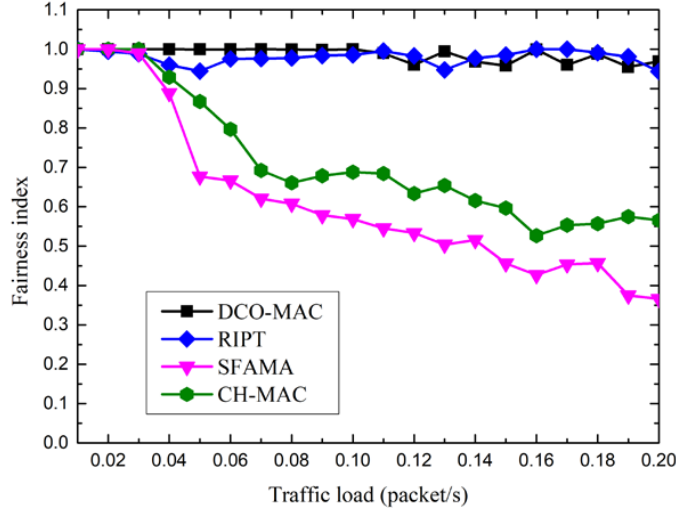
Figure 17. The fairness index of the DCO-MAC protocol.